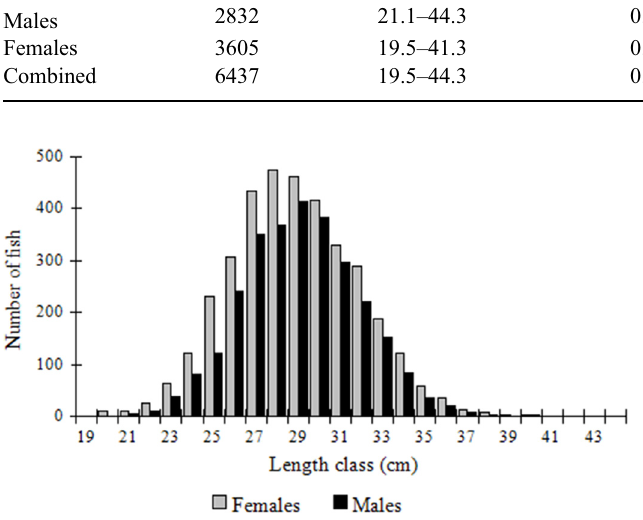
Fig. 2. Number of male and female Trachurus picturatus by length